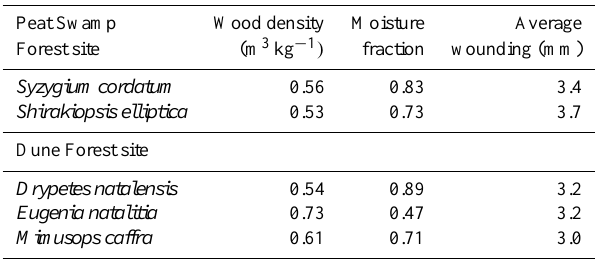
Table 2. Tree specific data required for calculation of sap flow. Peat Swamp Wood density